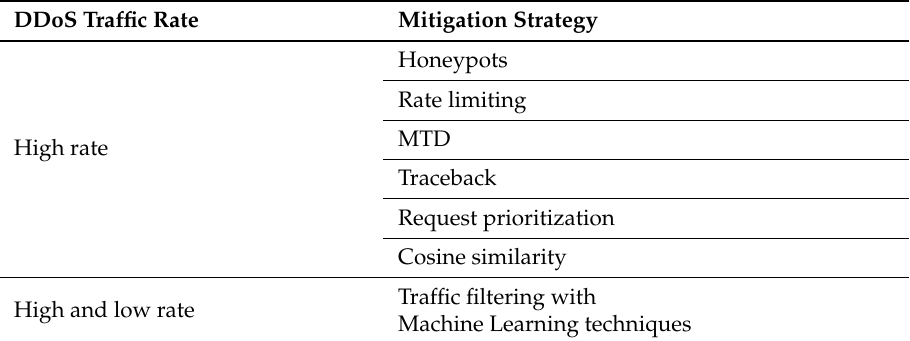
Table 5. Strategies employed in DDoS mitigation with low and high traffic rate.